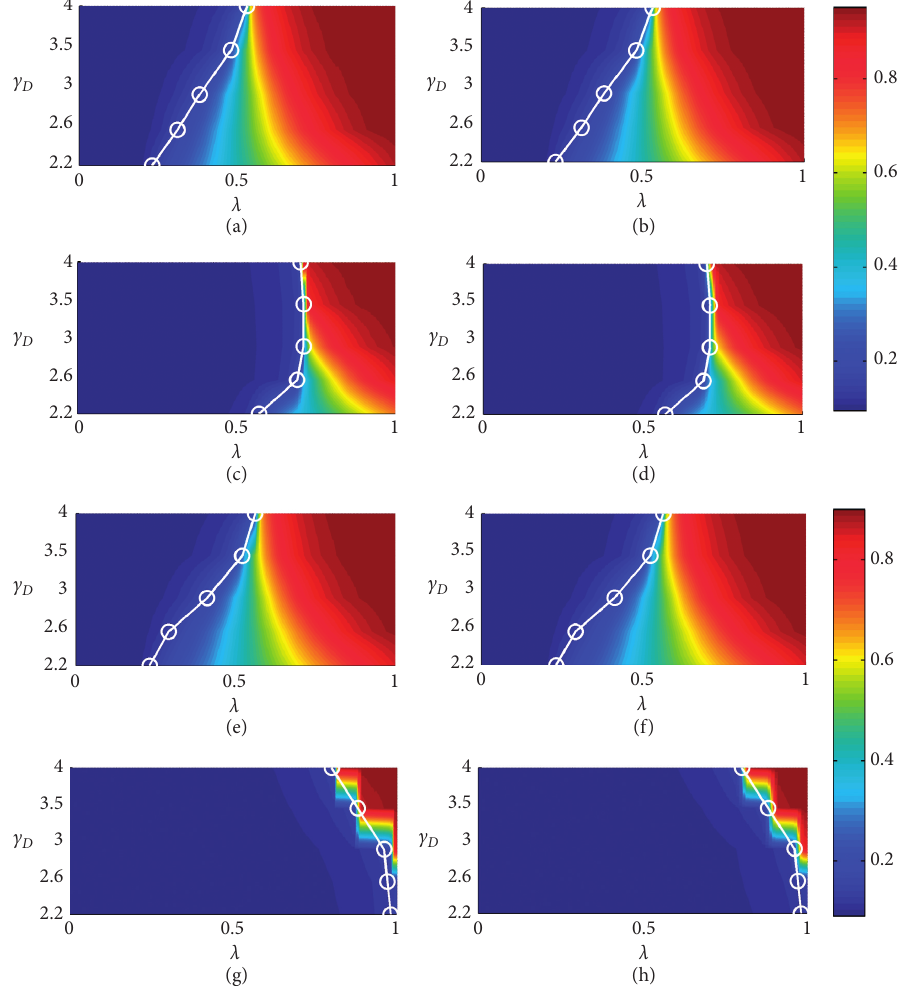
Figure 4: The final adoption size R ( ∞ ) versus information transmission probability λ and degree exponent c coded values of R ( ∞ ) from theoretical solutions in the plane λ − c D for (a) α � 0 , 1 − q � 0 . 05, (c) α � 4 , 1 − q � 0 . 05, (e) α � 0 , 1 − q � 0 . 1, and (g) α � 4 , 1 − q � 0 . 1. The corresponding simulated results for (b) α � 0 , 1 − q � 0 . 05, (d) α � 4 , 1 − q � 0 . 05, (f) α � 0 , 1 − q � 0 . 1, and (h) α � 4 , 1 − q � 0 . 1. The white circles are the simulated results of λ c